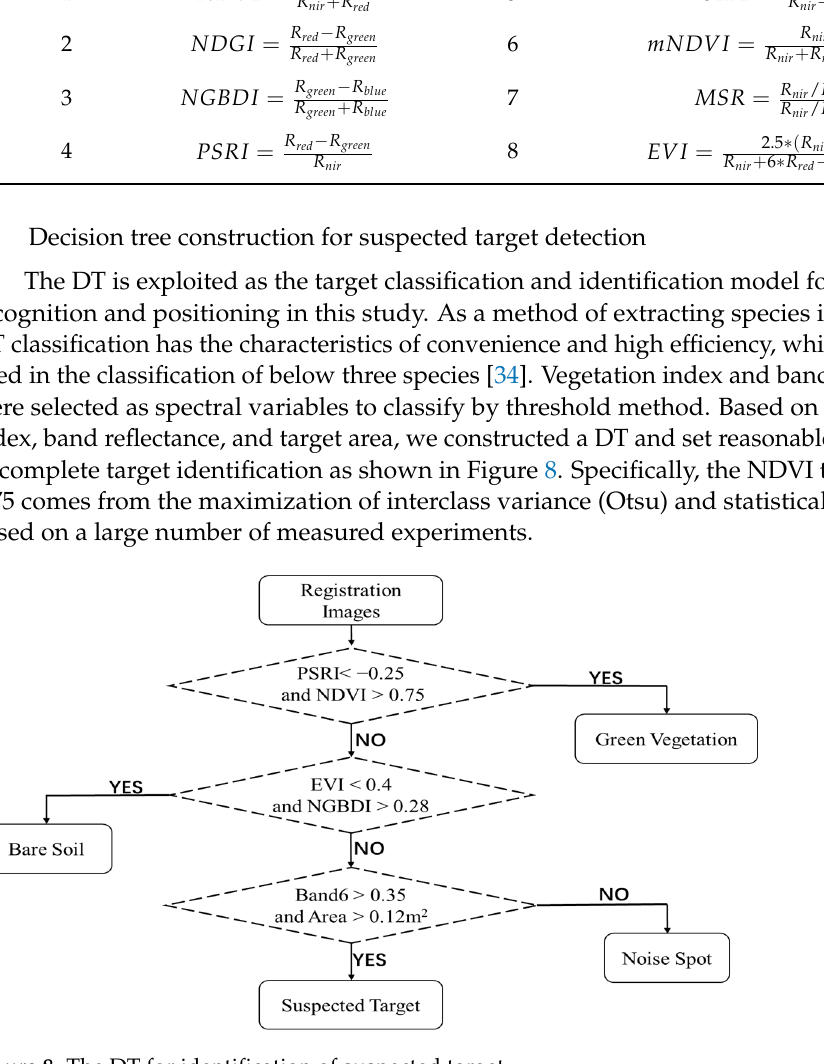
Figure 9. Block diagram of ALE. 𝑠(𝑘) is the useful respiration signal, 𝑛 (cid:2868) (𝑘) is noise signal, namely wideband sig- nal. 𝑠 (cid:2869) (𝑘) is the delayed respiration signal of 𝑠(𝑘) ; thus, they have a strong correlation after the delay, so the correlation between them is weak. According to the principle of self- use pair eliminator, during the process of 𝑒(𝑘) minimizing through 𝑧(𝑘) and 𝑦(𝑘) grad- ually becoming close, the only way is to make the 𝑠 (cid:2869) (𝑘) and 𝑠(𝑘) closest through FIR